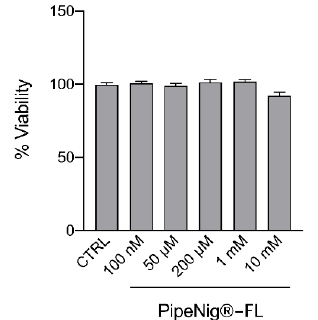
Figure 4. PipeNig ® -FL does not have any effects on cell viability in C2C12 muscle cell. C2C12 cells were treated with increasing concentration of PipeNig ® -FL for 1h. Data in percentage referred to control condition are represented as the mean ± SEM ( n = 3).